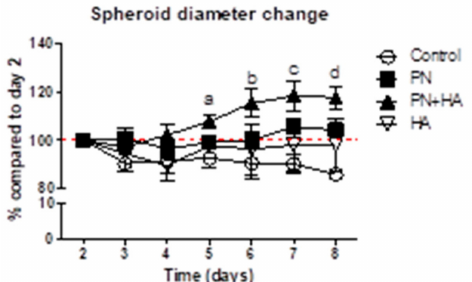
Figure 1. Spheroids were cultured on special cell-repellant culture plates and followed up for eight days. We measured spheroid diameter in vehicle-treated samples (Control) and compared it to Polynucleotides alone (PN), Hyaluronic acid alone (HA), or Polynucleotides in combination with Hyaluronic acid (PN + HA) groups, expressed as a percentage of the initial diameter. a = p < 0.05 PN + HA vs. all groups; b = p < 0.01 PN + HA vs. all groups; c, d = p < 0.001 PN + HA vs. all groups.